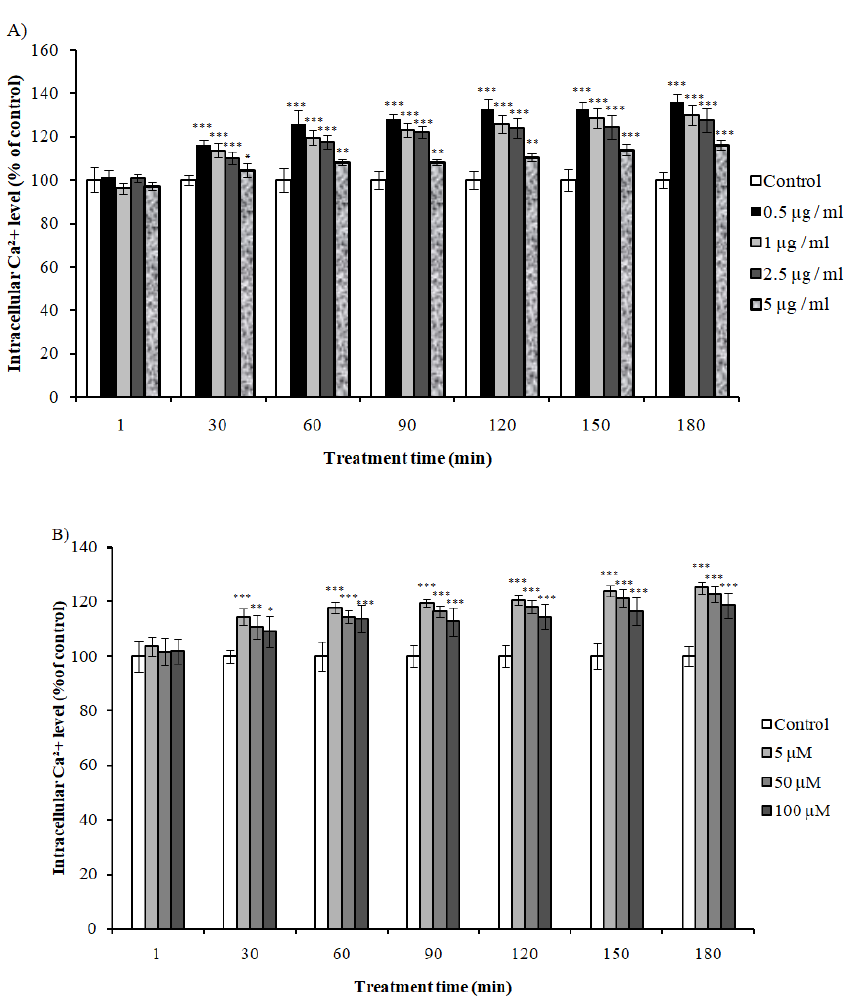
Figure 6. Evaluation of intracellular calcium levels of SH-SY5Y cells treated with di ff erent concentrations of ( A ) VEE and ( B ) Vs for 1–180 min. Results were expressed as percentage of control cells treated with Opti-MEM ± SD. * P < 0.05; ** P < 0.001; *** P < 0.0001 compared with control cells.